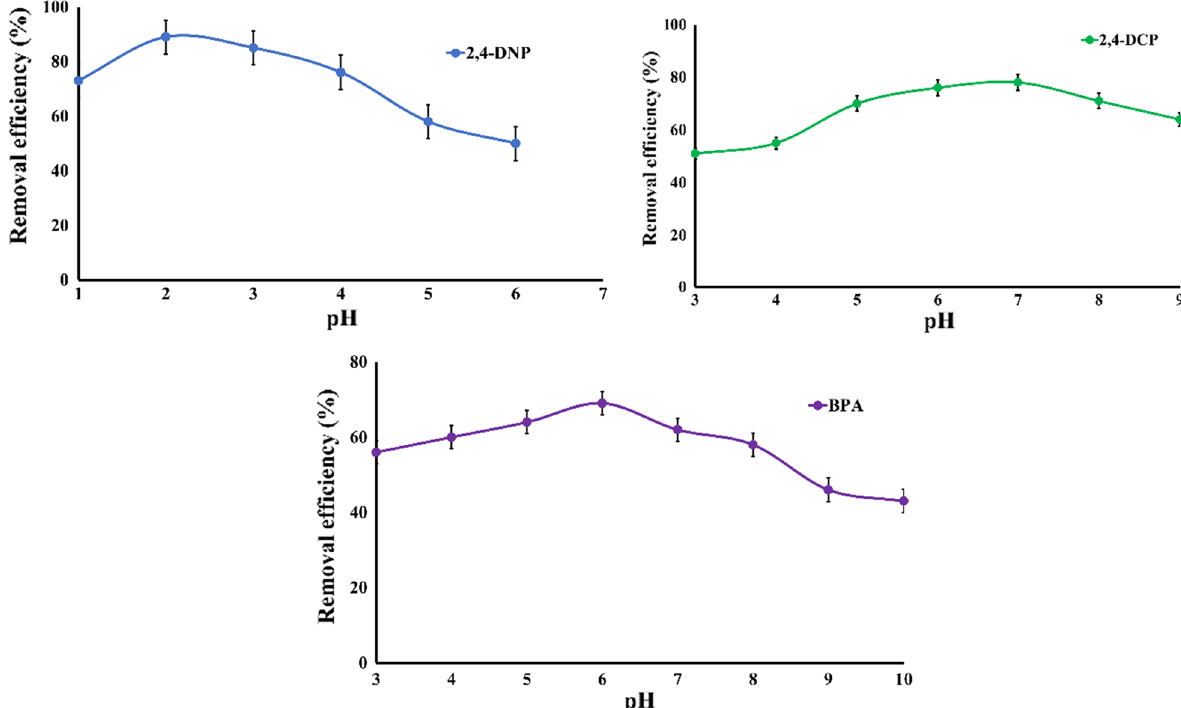
Fig. 6 Effect of pH on the adsorption efficiency of a DNP b DCP c BPA using Fe 3 O 4 @MAA-βCD as adsorbent. Conditions: (298 K, 10 mL of 10 mg L − 1 of analyte solution, 20 mg sorbent dose, at 250 rpm shaking